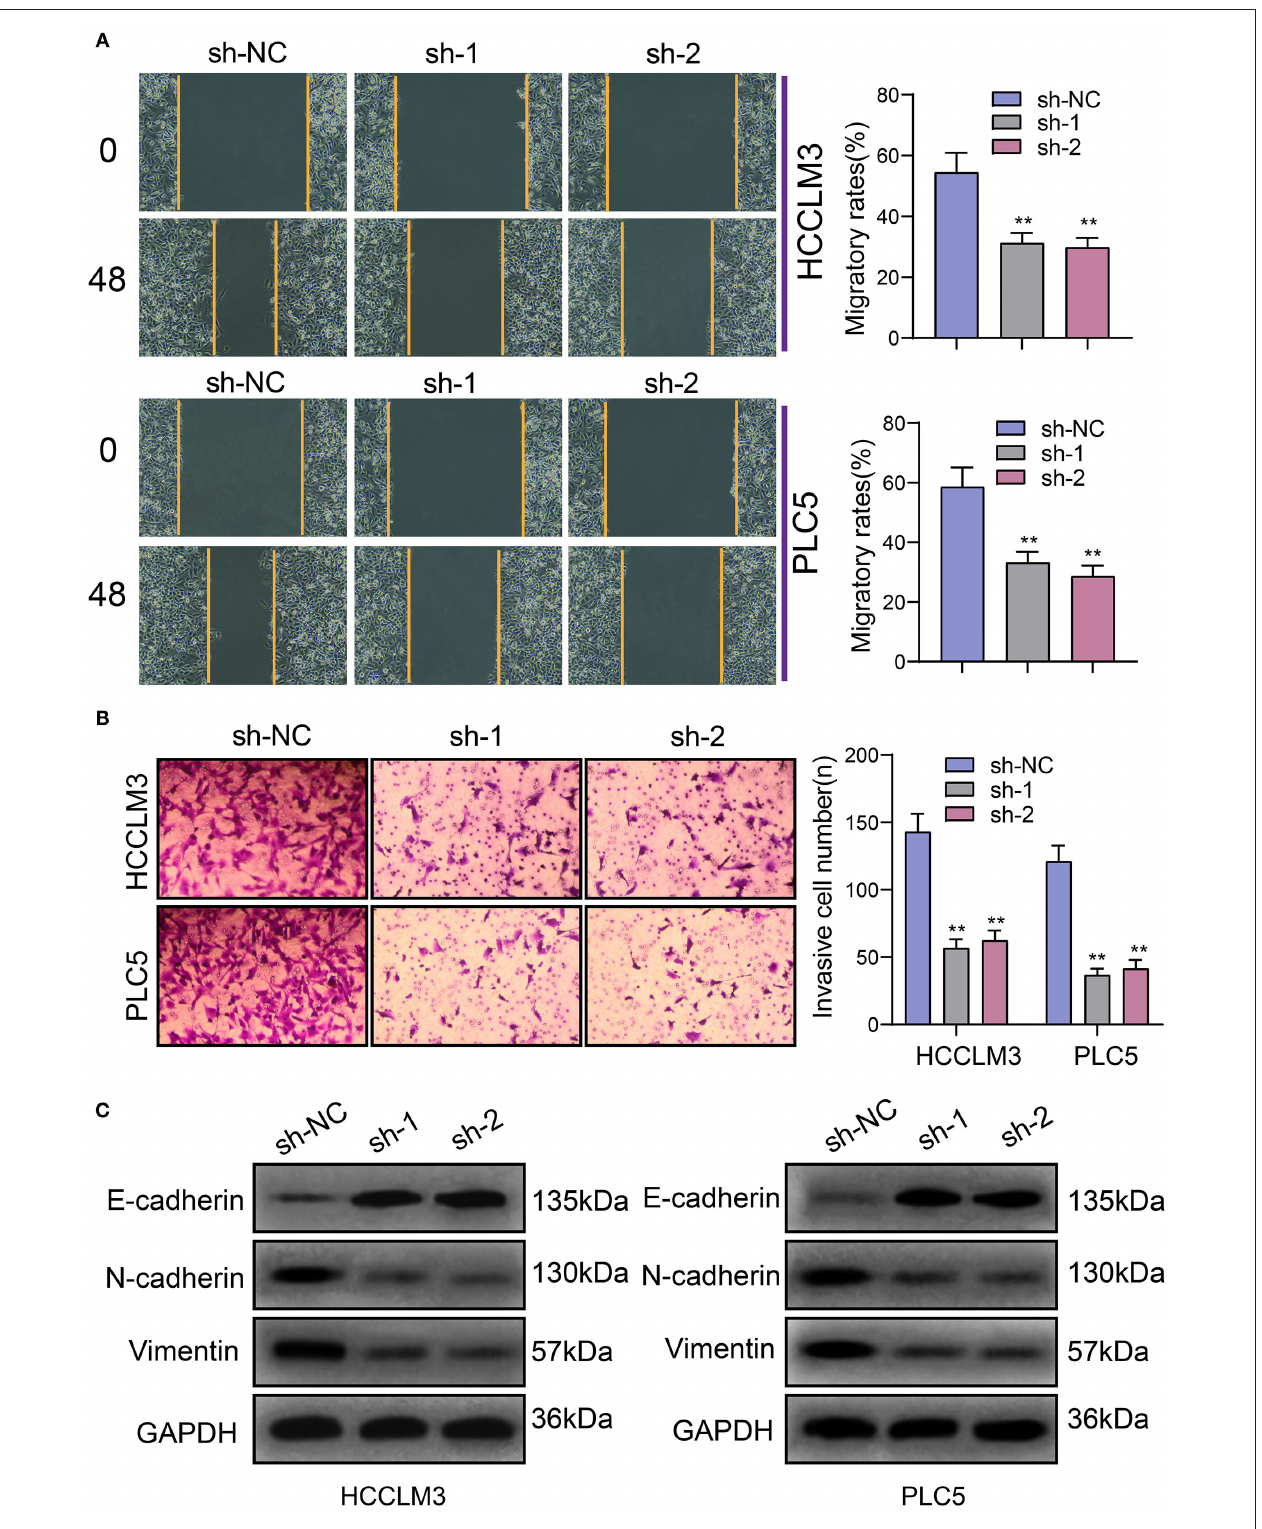
FIGURE 4 | Targeting PRKAG2-AS1 inhibits migration, invasion, and EMT process of HCC cells. (A) Wound healing assay for assessment of the migrated capacity of HCCLM3 and PLC5 cells transfected with PRKAG2-AS1 shRNAs. (B) Transwell assay for examining the number of invasive cells after PRKAG2-AS1 knockdown. (C) Western blot for measuring the expression of EMT-related proteins including E-cadherin, N-cadherin, and Vimentin in HCC cells transfected with PRKAG2-AS1 shRNAs or sh-NC. ** p < 0.01.